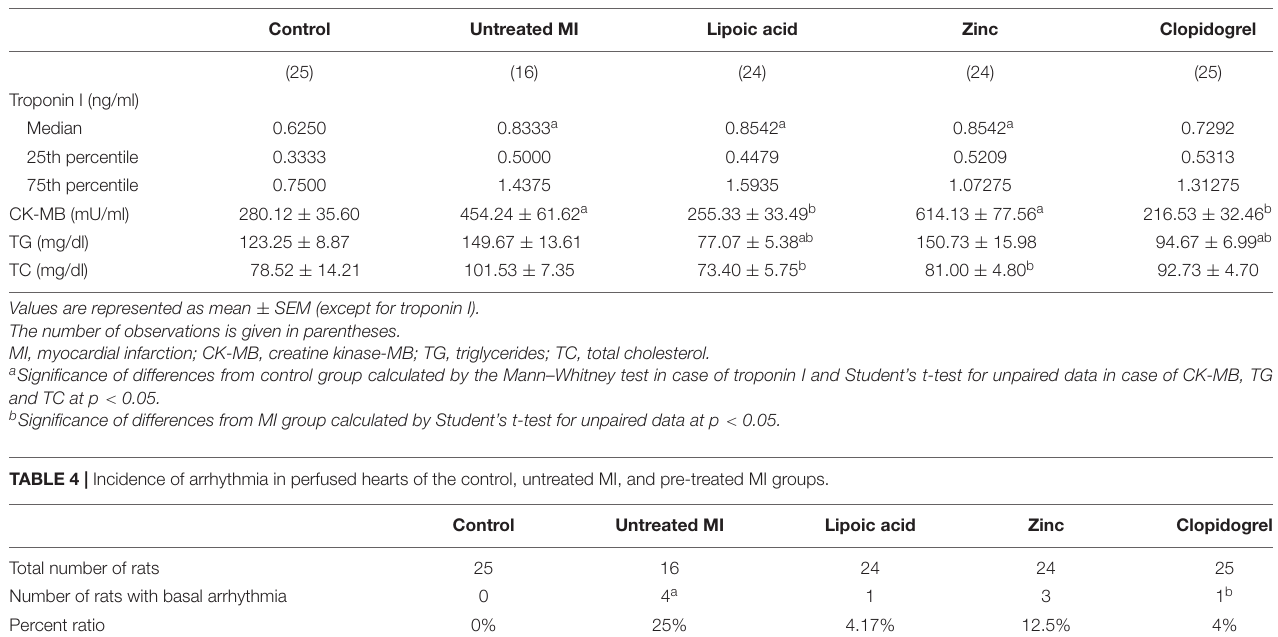
TABLE 3 | Plasma levels of troponin I, creatine kinase-MB, triglycerides and total cholesterol in the control, untreated MI, and pre-treated MI